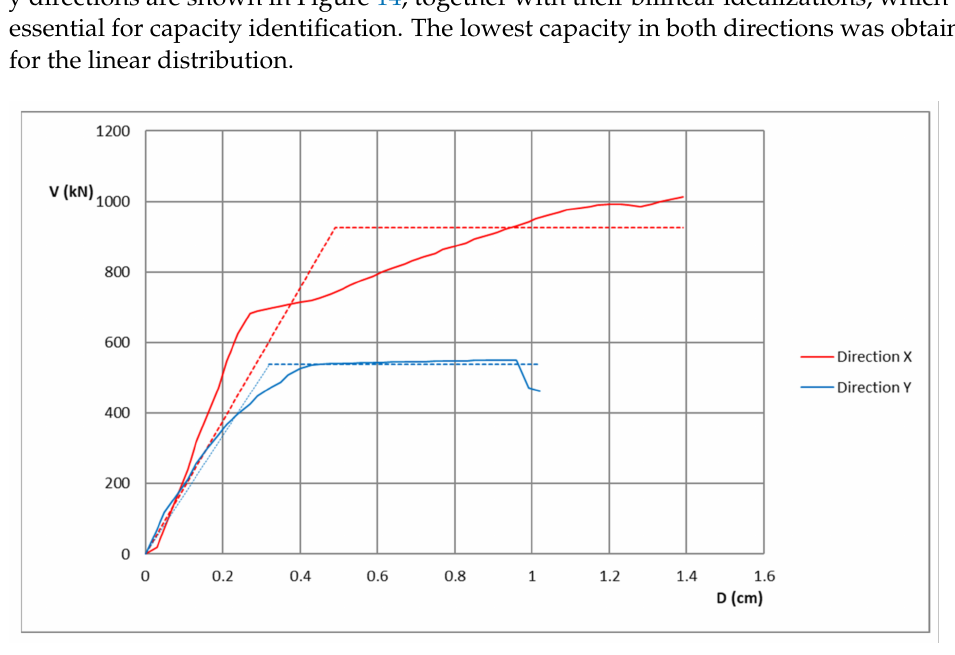
Figure 14. The worst cases of pushover